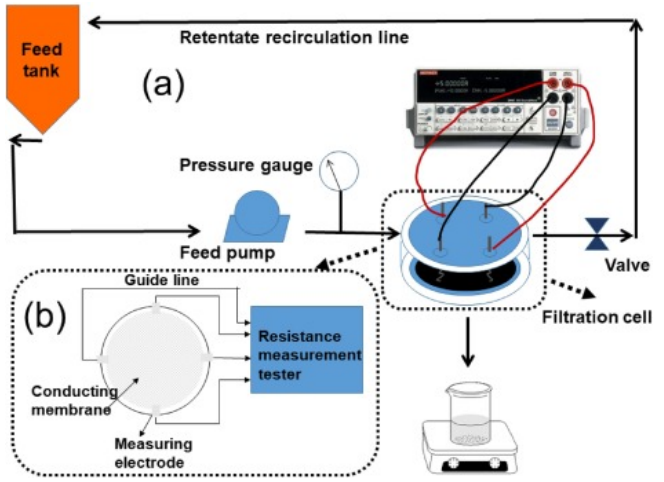
Figure 7. An example of fouling monitoring by electrically responsive membranes. Reproduced with permission from [80] .